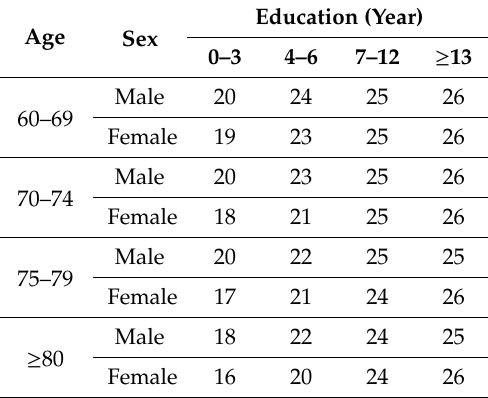
Table 1. Norm-referenced cuto ff scores of Mini-Mental Status Examination for Dementia Screening